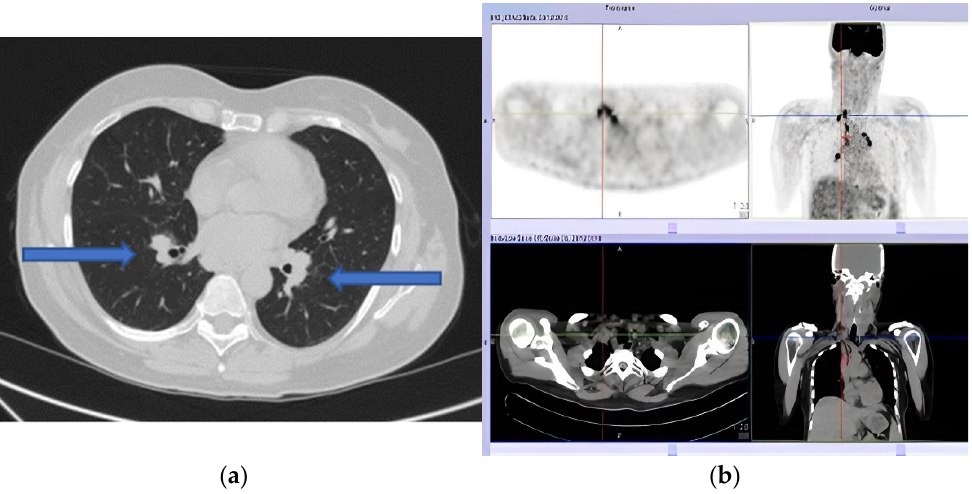
Figure 1. ( a ) Pulmonary computed tomography (CT) scan showing multiple bilateral lymphade- nopathies. ( b ) Positron emission tomography (PET) showing multiple adenopathies with a high metabolic